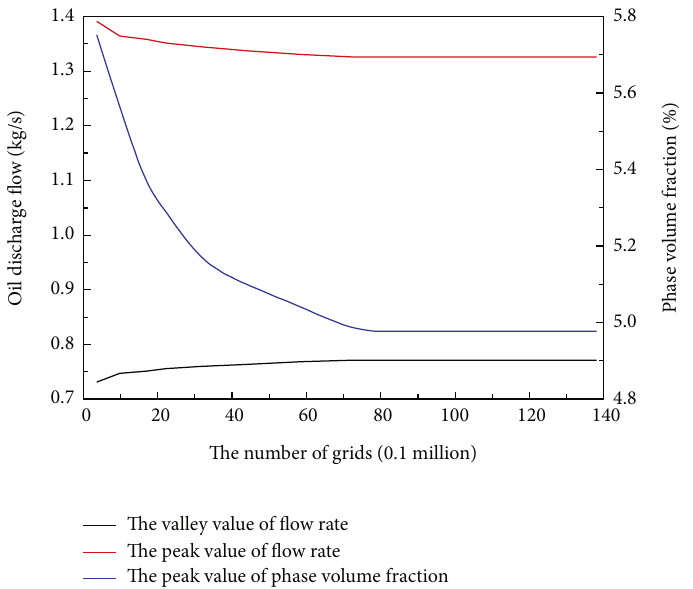
Figure 8: The variation curves of three characteristic parameters with the number of grids.